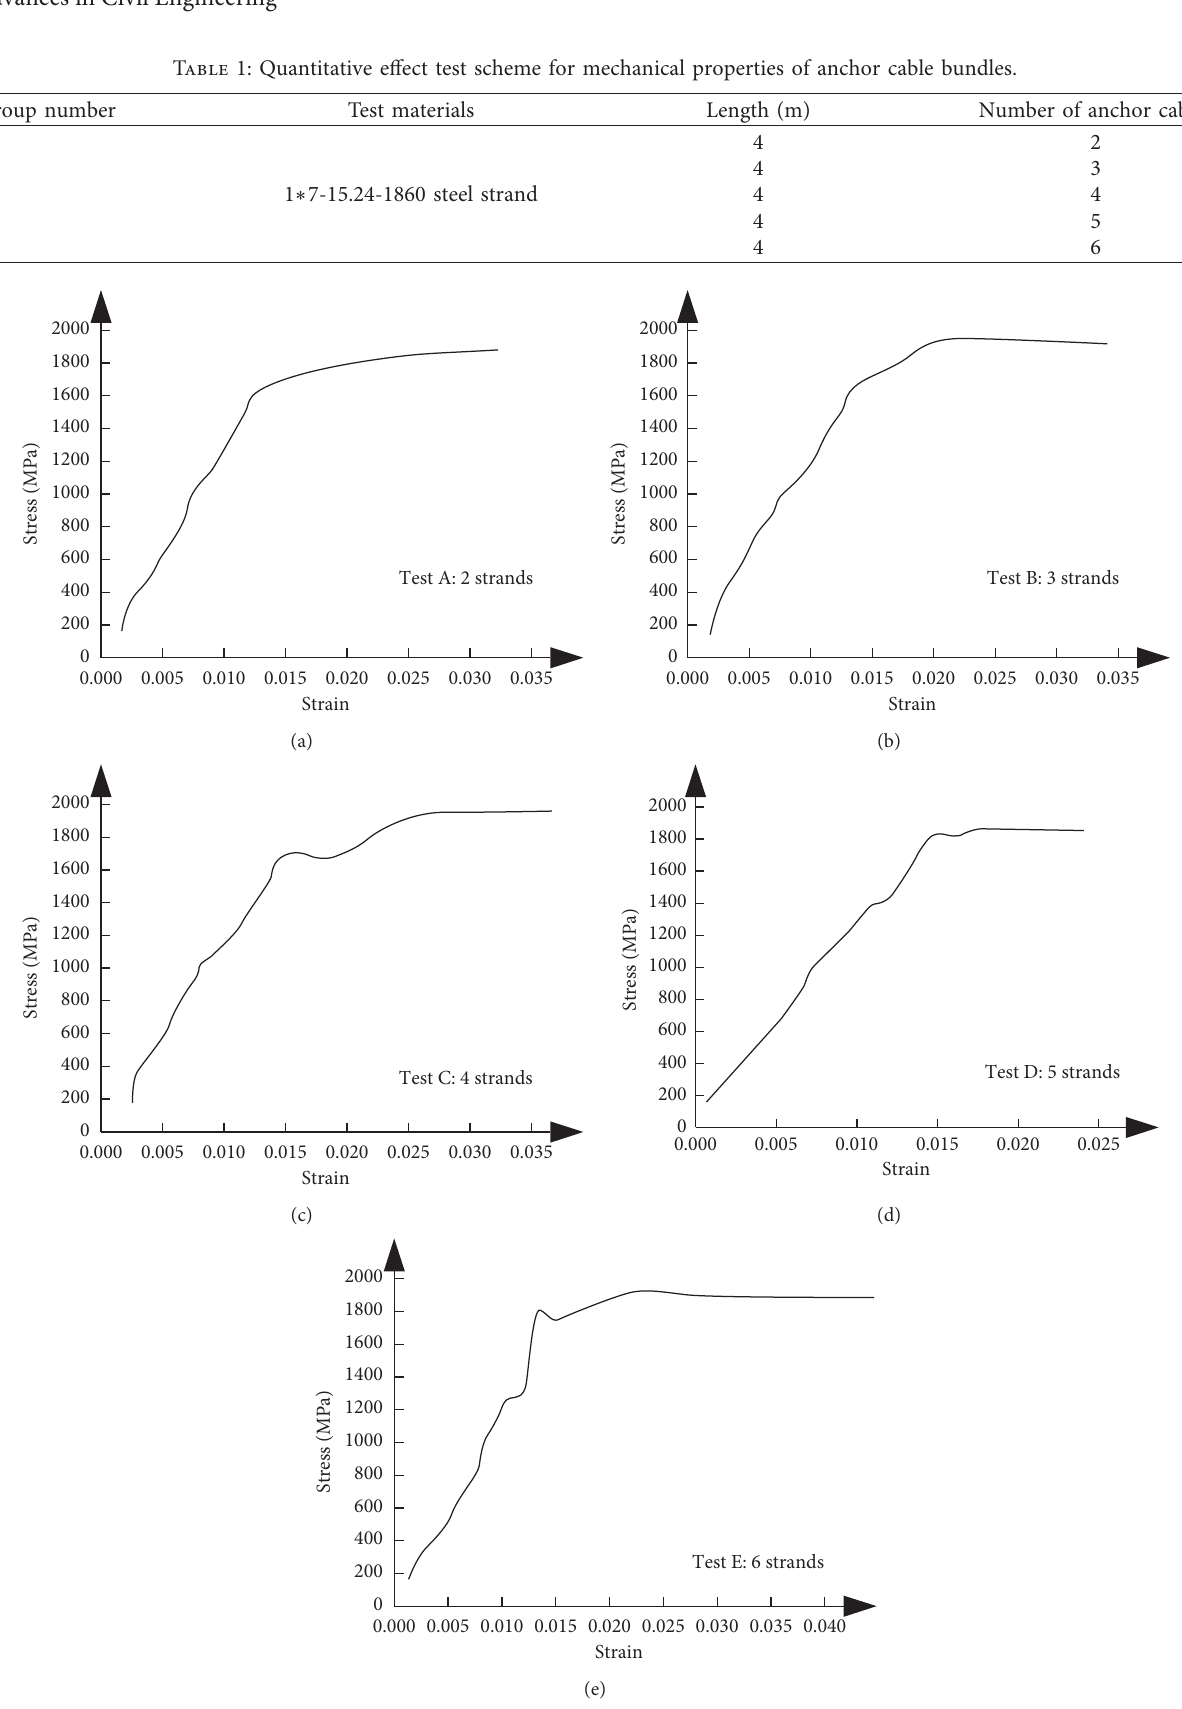
Figure 1: Static tensile test results with varying strand numbers. (a) Static tensile test results of 2 strands, (b) static tensile test results of 3 strands, (c) static tensile test results of 4 strands, (d) static tensile test results of 5 strands, and (e) static tensile test results of 6